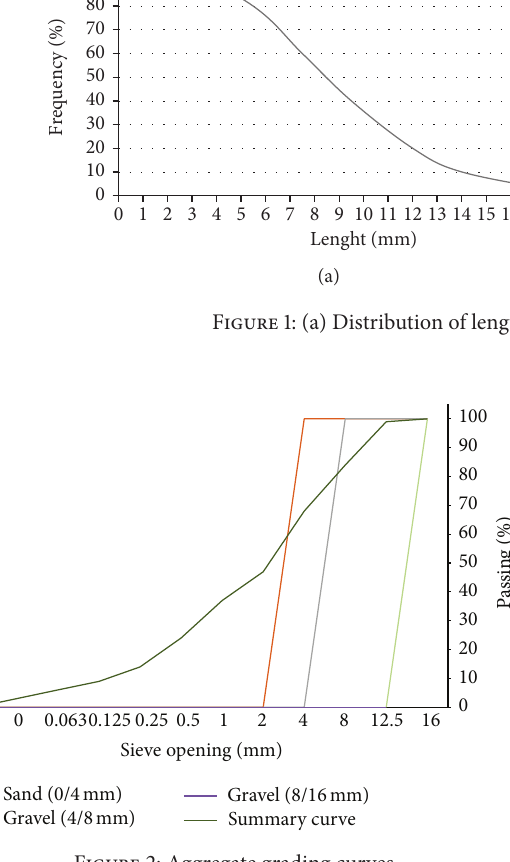
Figure 2: Aggregate grading